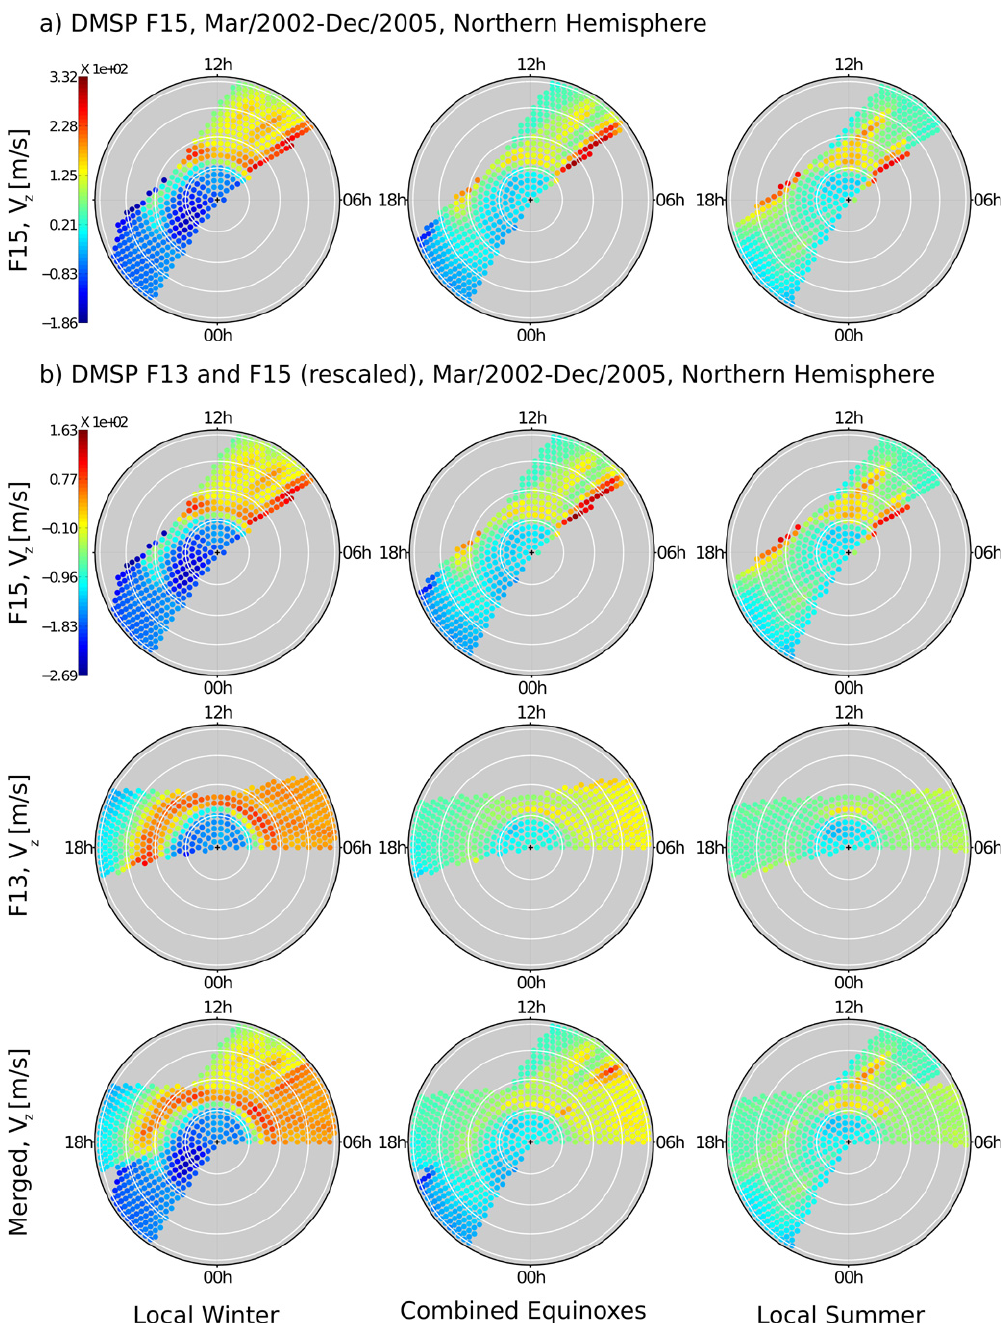
Fig. 4. The bin-averaged median values of ion vertical velocity for the three local seasons: winter (left column), combined equinoxes (middle column), and summer (right column): (a) DMSP F15; (b) rescaled DMSP F15 (according to Eq. 6), DMSP F13, and their merged plots from top to bottom. The white circles mark the MLat at 10 ◦ spacing.